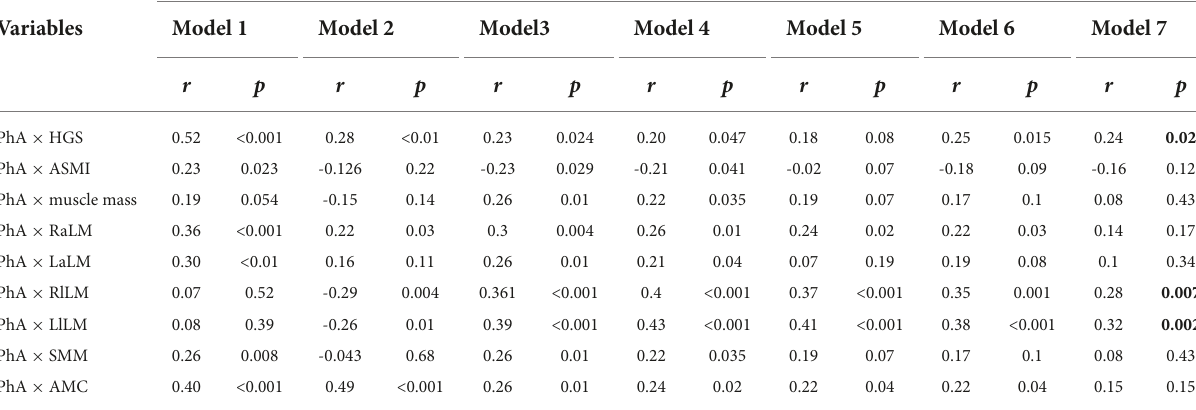
TABLE 2 The Pearson correlation between PhA with Indicators related to sarcopenia.